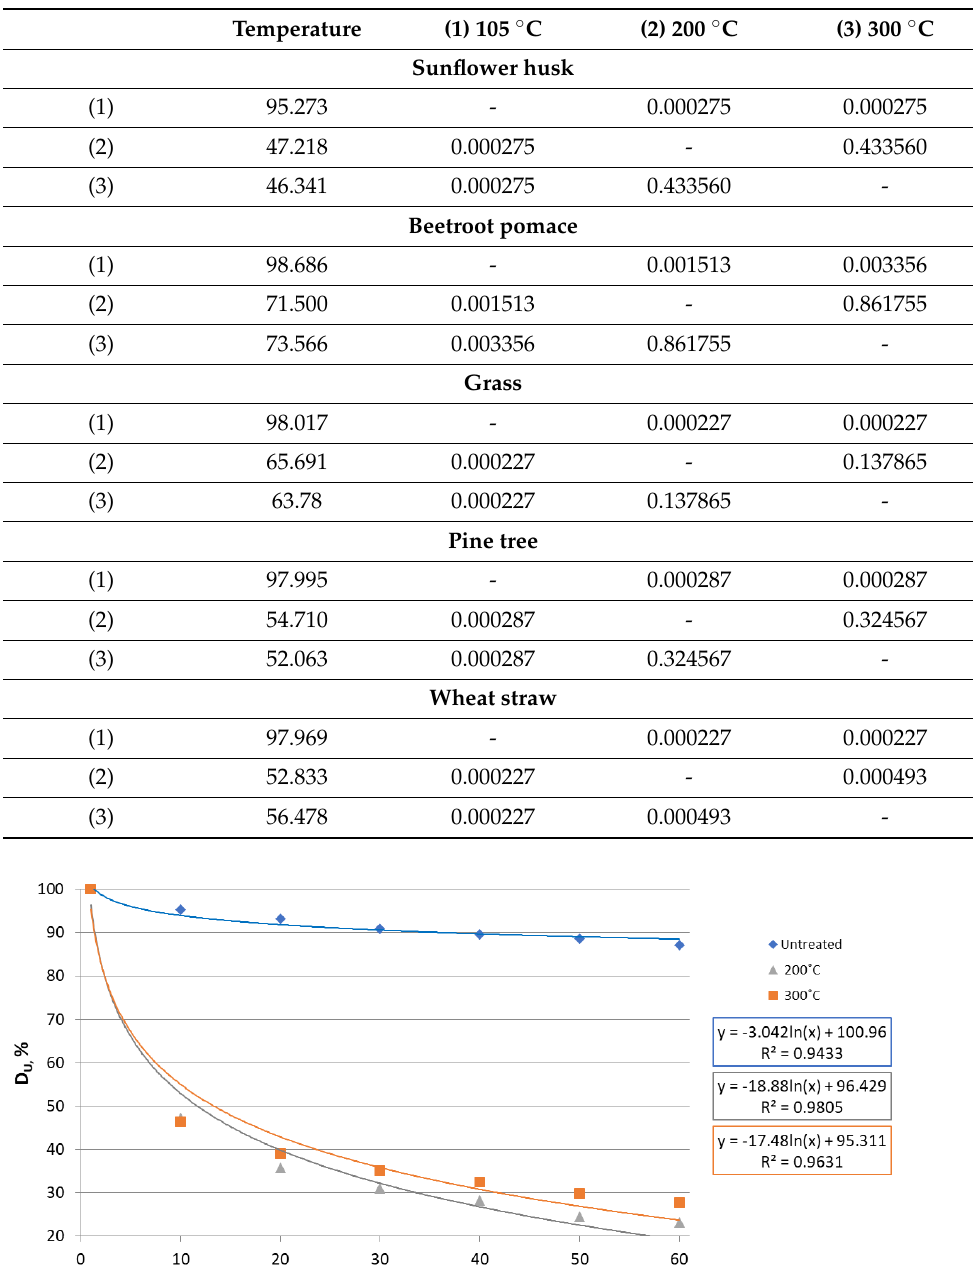
Table 2. Statistical results of the ANOVA and post hoc Tukey test of the influence of torrefaction temperature on the mechanical durability for a 10 min operation time.